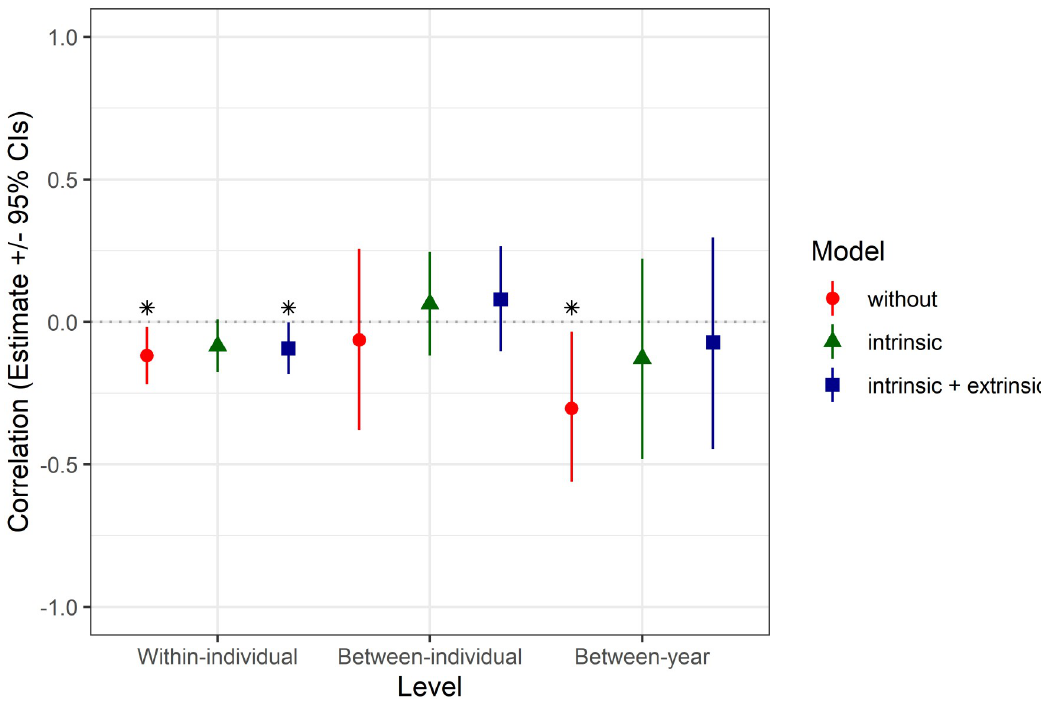
Fig 5. Correlations between δ 13 C oto and growth increment width (mean value and 95% credible intervals) estimated within- individual, between-individual, and between-years with the models incorporating different sets of effects (indicated with colors). Significant correlations where credible intervals do not overlap zero are indicated with